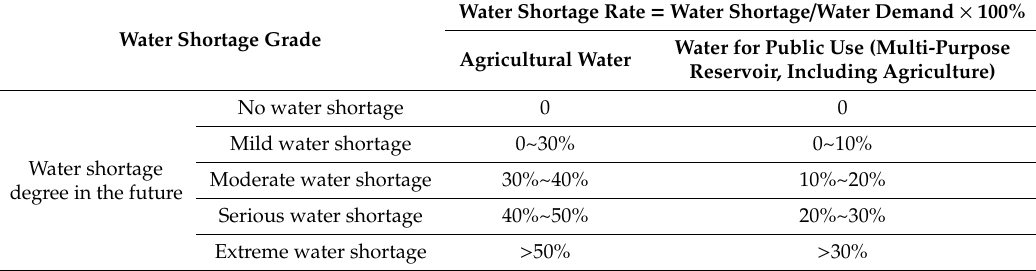
Table 2. Water source situation index